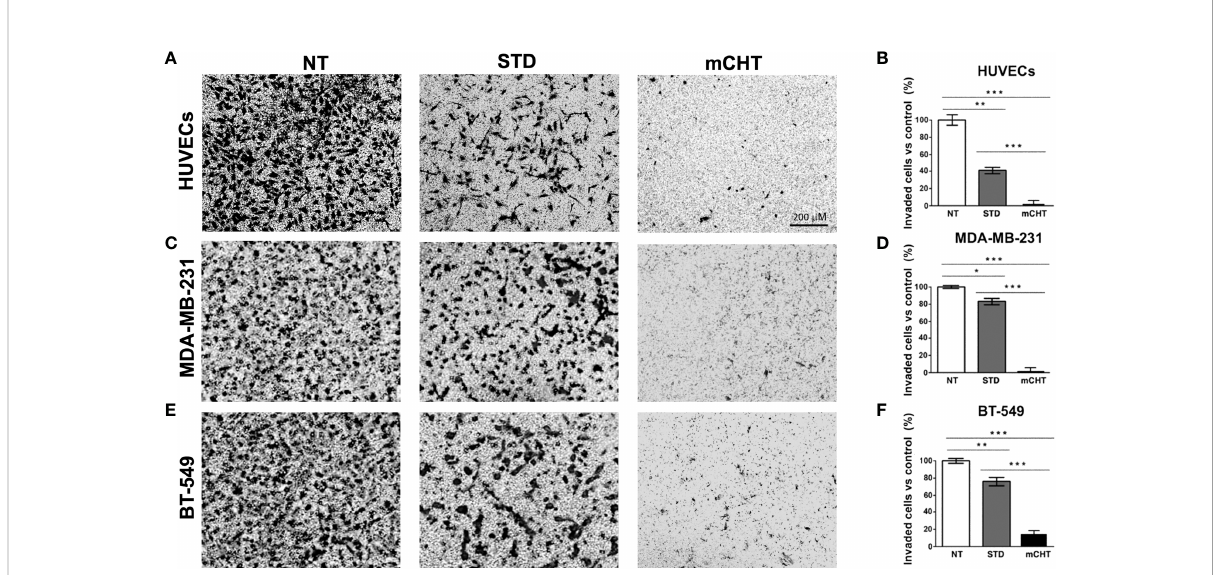
FIGURE 5 Metronomic treatment with 5-FU+VNR inhibits HUVECs and TNBC cell invasion more ef fi ciently than standard administration. Representative images of Transwell assay on HUVECs (A) , MDA-MB-231 cells (C) and BT-549 (E) treated for 96h under the STD or mCHT protocol and performed as described in Material and Methods. Cells that invaded through the Matrigel ‐ coated membrane were stained with crystal violet, counted, and graphically expressed as a percentage of the untreated control (B, D, F) . Values represents the average ± SD of three independent experiments. *p < 0.05; **p < 0.01; ***p <